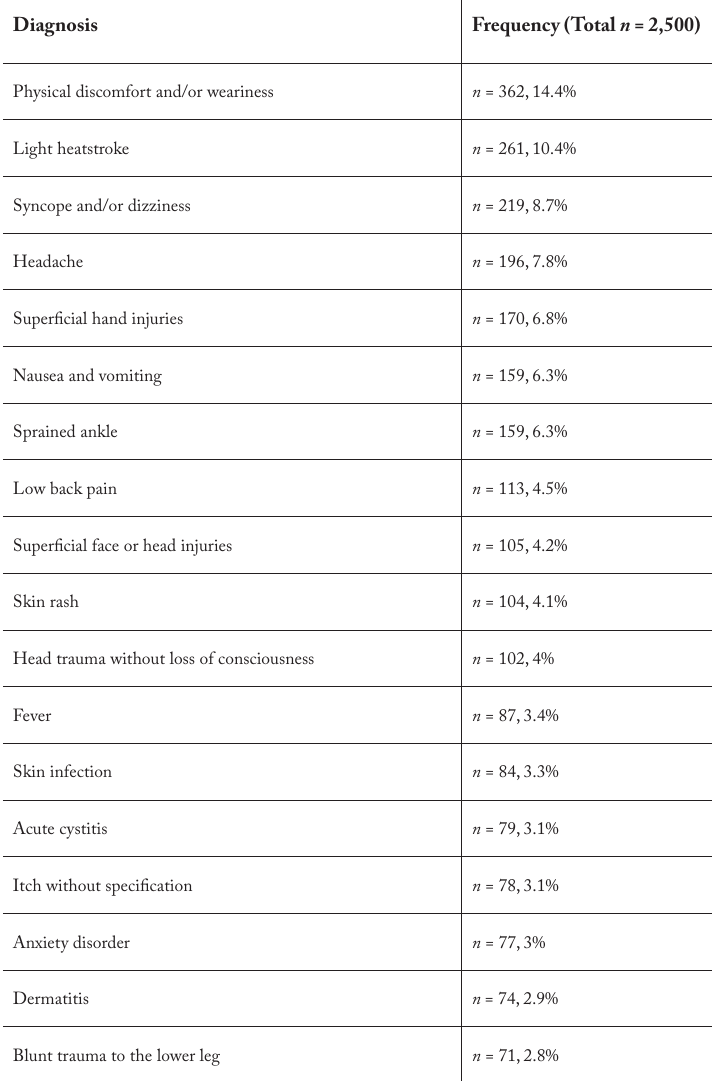
Table 1 . Prevalence of the most frequent medical and trauma